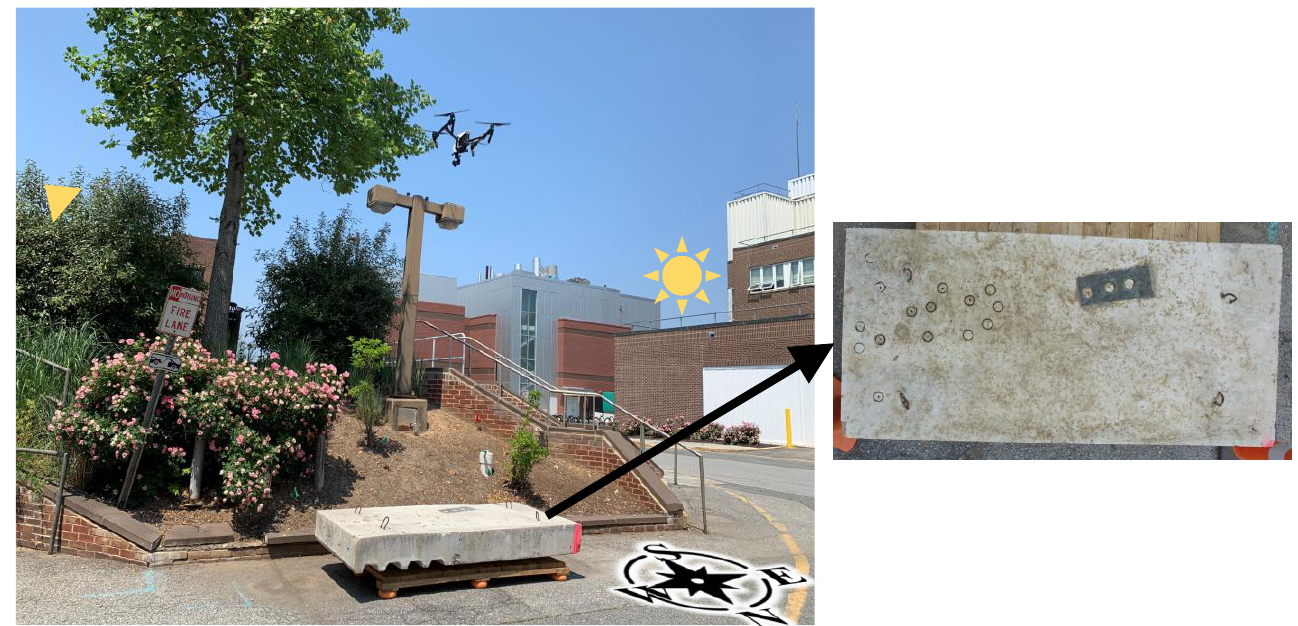
Figure 5. Mimicked slab during the data collection process.